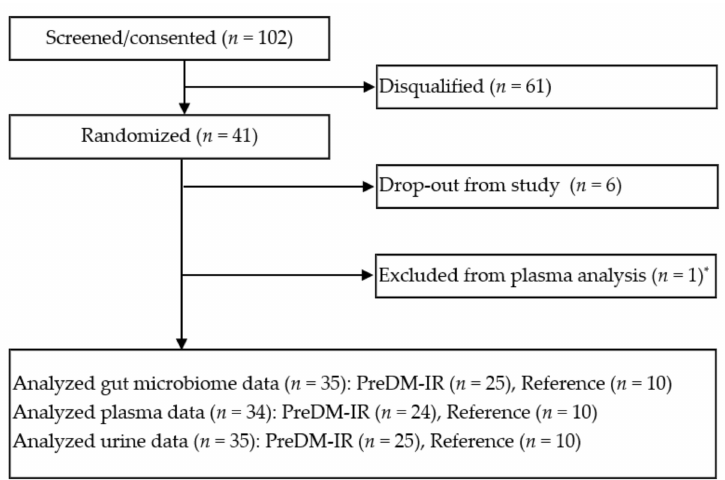
Figure 2. Consolidated Standards of Reporting Trials (CONSORT) flow diagram of the study. * Fail in blood collection. Table 2. Dietary intake assessment of PreDM-IR (prediabetes and insulin-resistance) and Reference groups 1 . Nutrient and Food Group PreDM-IR ( n =